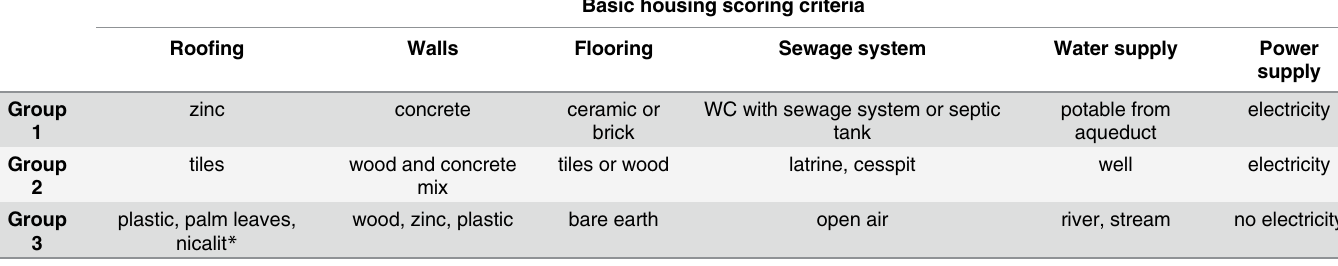
Table 1. Living conditions scoring